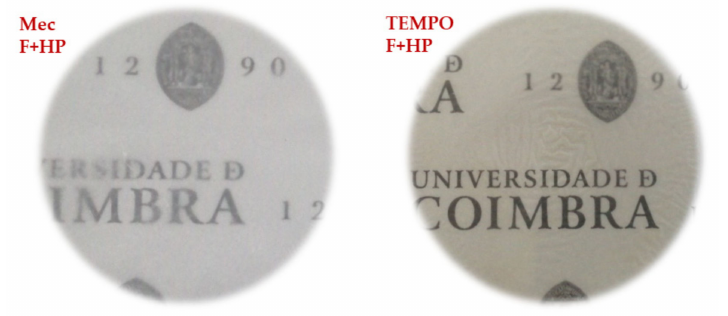
Figure 2. Digital photographs of the films prepared by filtration + hot pressing from CNF Mec ( left ) and TEMPO CNF ( right ).